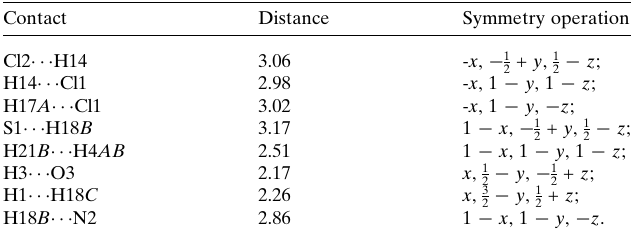
Table 2 Summary of short interatomic contacts (A˚ ) in the title compound. Contact